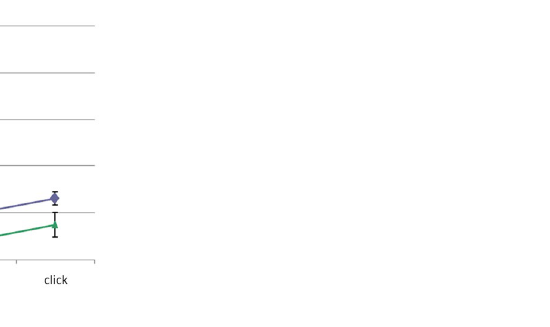
Figure 5. Hearing thresholds of adult Cx30 Δ / Δ mice four weeks after delivery of BAAVCx30GFP viral vector at P4 and their respective age-matched non-injected controls. Error bars represent s.e.m.; differences are significant for 32 kHz (p = 0,022) and click responses (p = 0,043) (two tailed